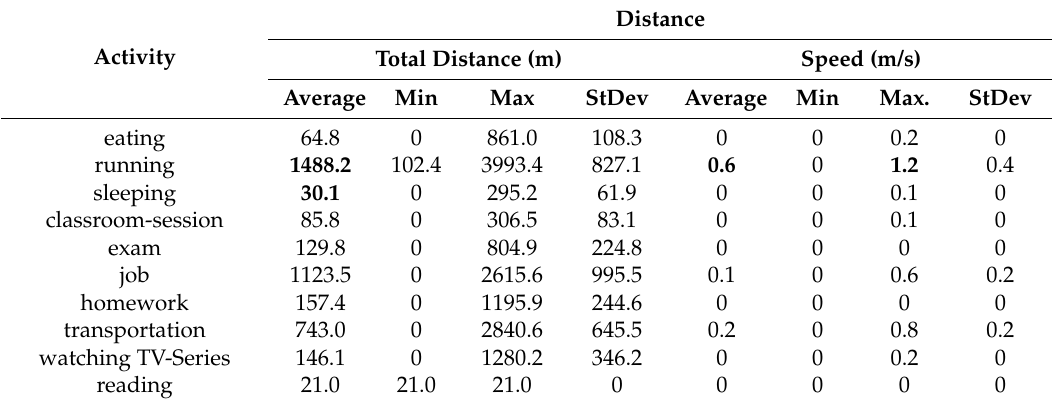
Table 5. Distance by